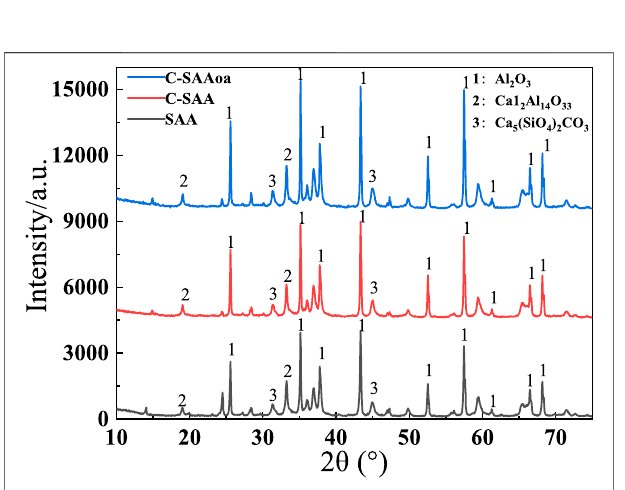
FIGURE3 | (A) SEM images and EDS spectra of C-SAA before adsorption, (B) SEM images and EDS spectra of C-SAA oa before adsorption, (C) SEM images and EDS spectra of C-SAA after adsorption, (D) SEM images and EDS spectra of C-SAA oa after adsorption.